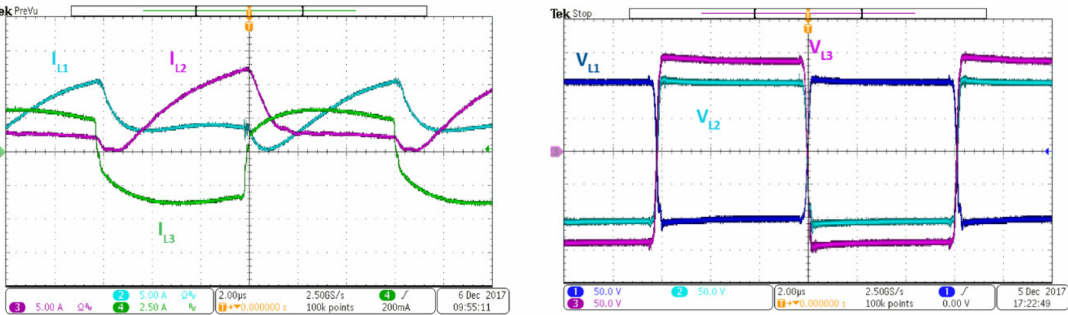
Figure 8. Time waveforms received from experimental measurements of the MPPT converter. ( left ) Waveforms of the inductor’s currents; ( right ) Waveforms of the inductor’s